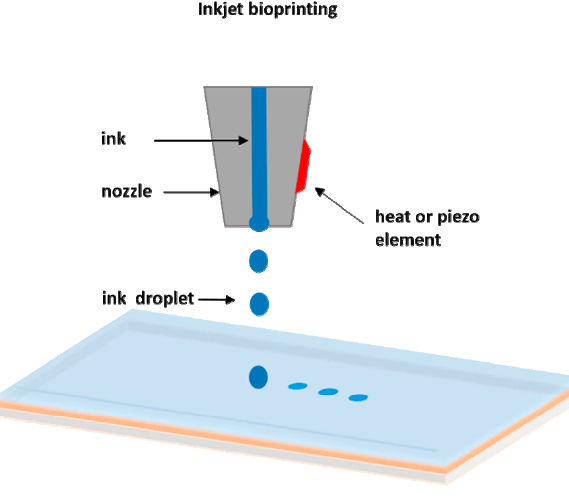
Figure 2. Schematic representation of inkjet printing.